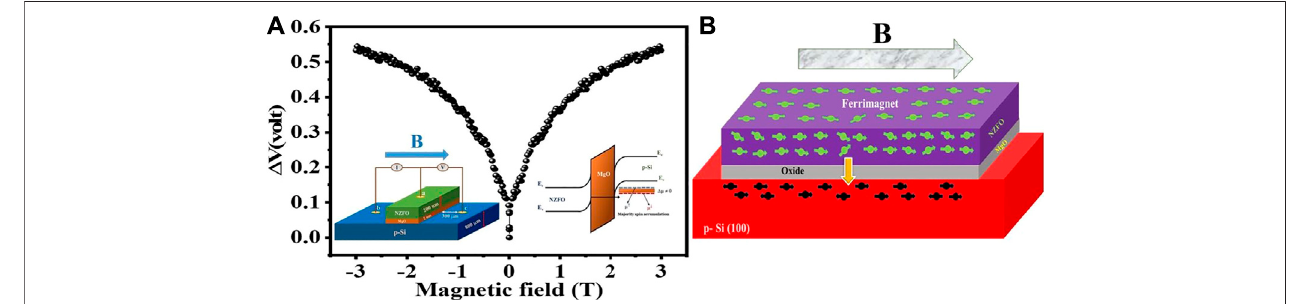
FIGURE11| (A) Response of Δ V(spinaccumulation in p-Si) at 300 K with the applied longitudinal magnetic fi eld with aconstant bias current of5 µA. The inset on the left side depicts the three-terminal Hanle geometry.The inseton the right side illustrates the energy-band pro fi le of the NZFO/MgO tunnel contact with p-Si. (B) Spin accumulation and spin-splitting of electrochemical potential in the Si valence band are caused by the injection of spin-polarized holes.